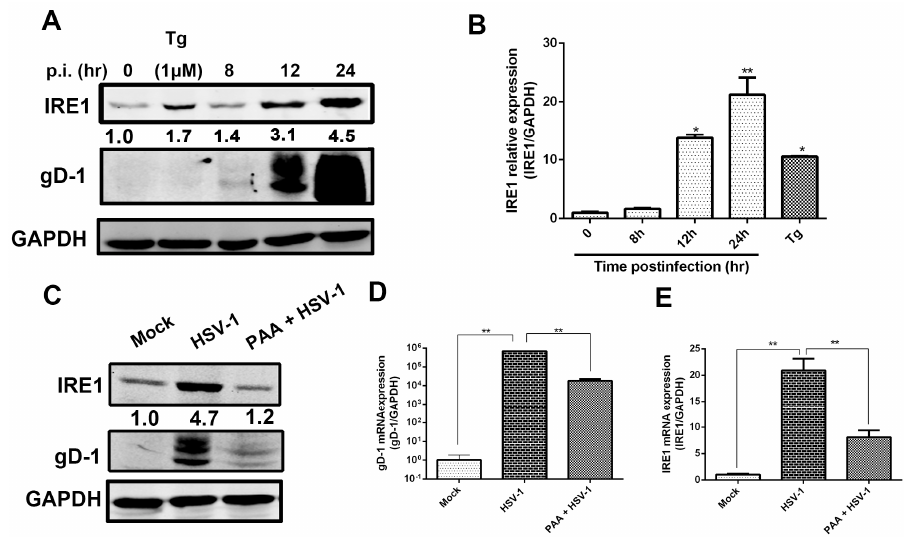
Figure 1. Inositol-requiring enzyme 1 (IRE1 α ) expression is up-regulated by herpes simplex virus type 1 (HSV-1) infection. ( A , B ) HSV-1 infection increased IRE1 α expression in HEC-1-A cells. HEC-1-A cells were infected with HSV-1 (strain HF) at multiplicity of infection (moi) = 1. ( A ) Total cellular protein was harvested at indicated time point p.i. (post infection) and subject to Western blot analysis using antibodies against total IRE1, gD-1 (Glycoprotein D) and GAPDH (glyceraldehyde 3-phosphate dehydrogenase). The number under each band represents the relative density of the band in comparison to the corresponding control normalized to GAPDH. Cells treated with Thapsigargin (Tg) (1 μ M) harvested at 4 h was used as a positive control; ( B ) IRE1 α transcription expression was determined by real-time PCR at various time points post-infection (p.i.). Total RNA was extracted, IRE1 mRNA level was measured by real-time PCR and normalized to GAPDH. Cells treated with Tg (1 μ M) for 4 h was served as control. The data are presented as mean ± standard deviation (SD) from three independent determinations (* p < 0.05, ** p < 0.01); ( C – E ) Both IRE1 α and gD expression were inhibited by PAA. HEC-1-A cells were pretreated or mock-pretreated with phosphonoacetic acid (PAA, 400 μ g/mL) for 30 min and then infected or mock-infected with HSV-1 (HF) at moi = 1. Both protein and mRNA transcription levels of IRE1 α and gD-1 at 24 h p.i. were determined. Columns and bars represent the mean ± SD of three independent experiments (** p < 0.01). All experiments were performed three times. Representative results are shown.